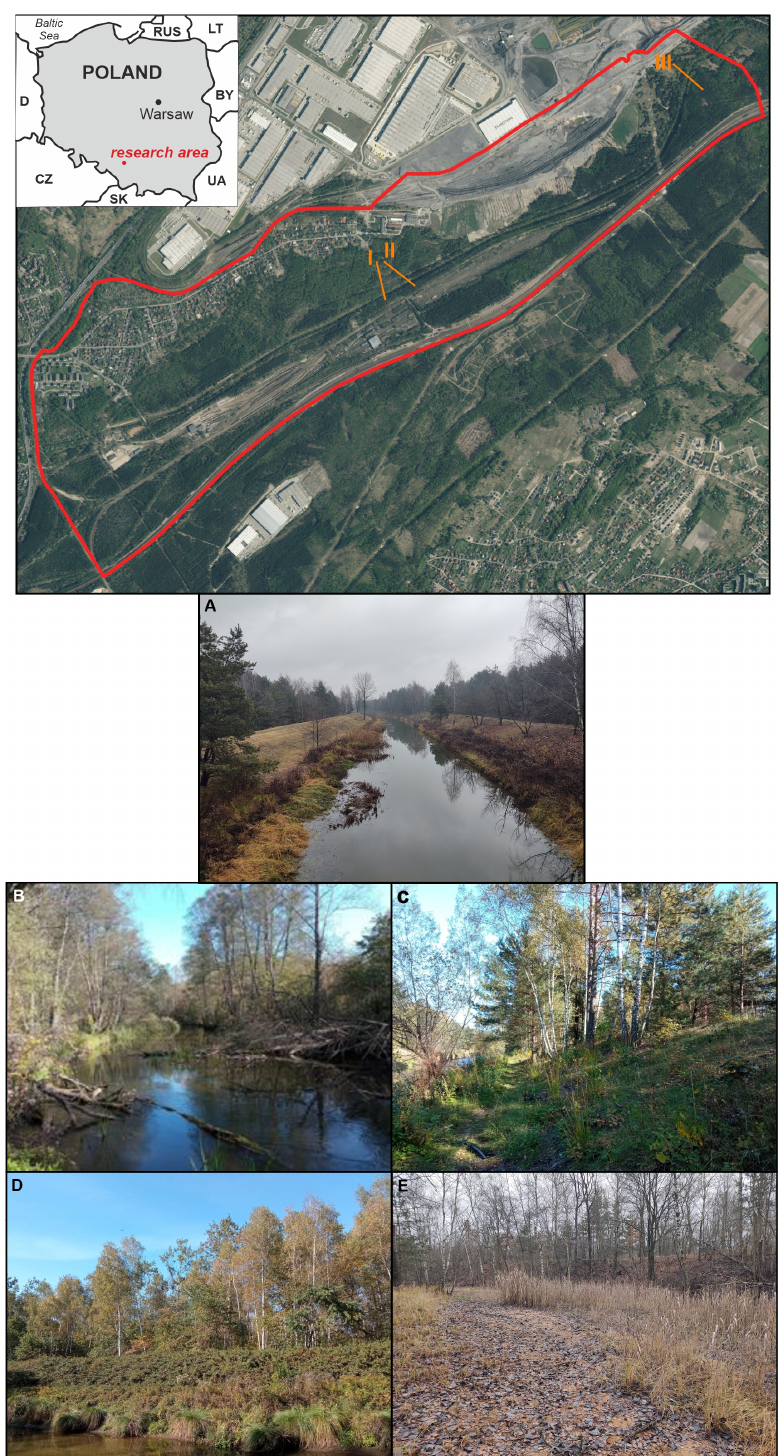
Figure 1. Location of study area: ( A ) general view of the straightened deposit together with a narrow patch of rushes; ( B ) unregulated section of the river with riparian forest; ( C ) mixed forest on the slope of an artificial embankment. ( D ) The slopes and tops of the embankment are fortified by Spiraea salicifolia, and the bank of the riverbed by a belt of rushes and ( E ) reed rushes on the old riverbed, where occasional water collects on the impermeable substrate.